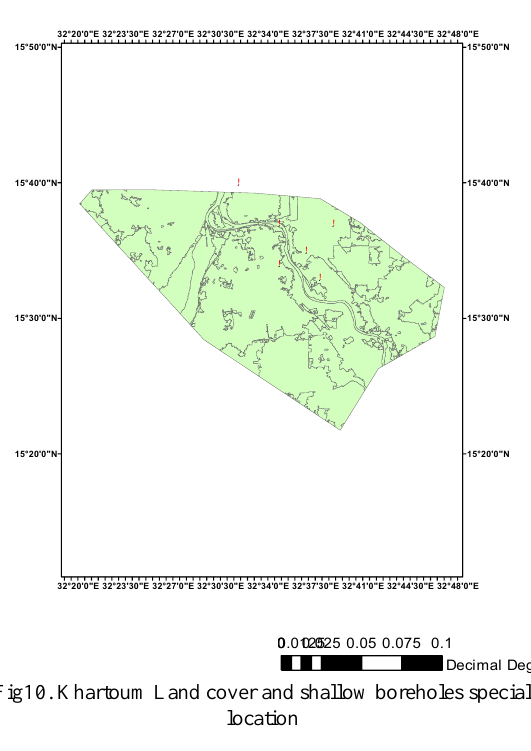
Fig 6.N-Kordofan, Bara- Nitrogen15 Distribution Using IDW Interpolation